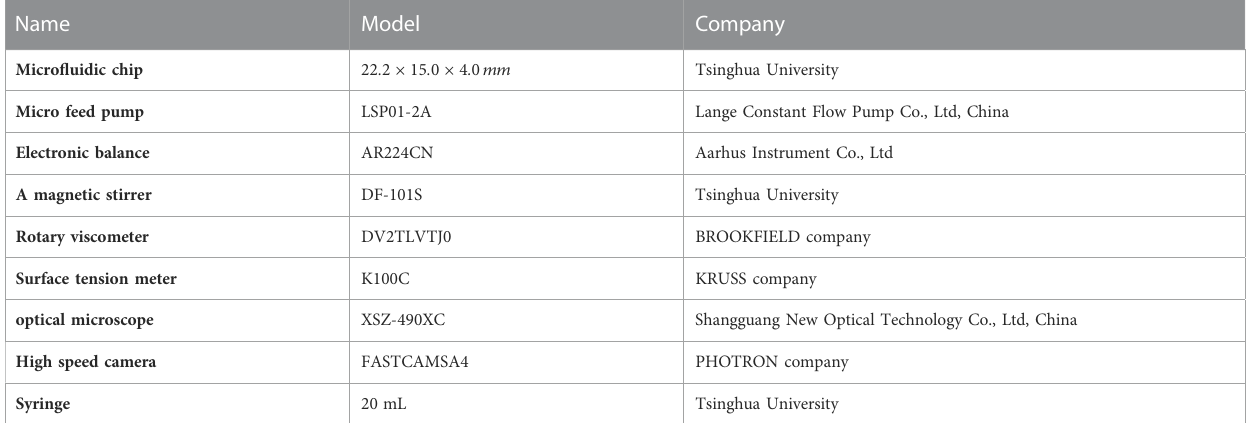
TABLE 2 The main experimental equipment of